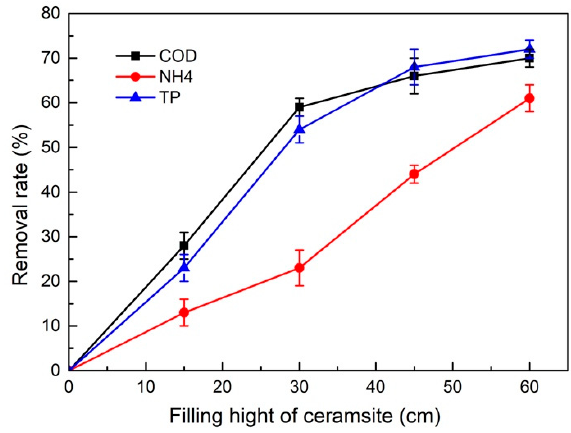
Figure 6. Chart of COD, NH 3 -N and TP removal at different filling heights.